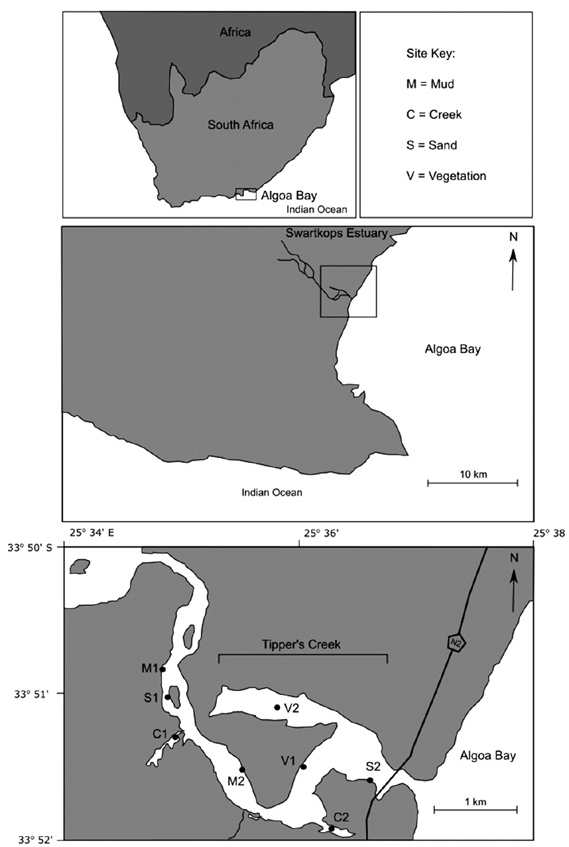
Fig. 1. – Geographic location of the Swartkops Estuary, South Af- rica, showing the location of the sampling sites in the lower 3 km of the